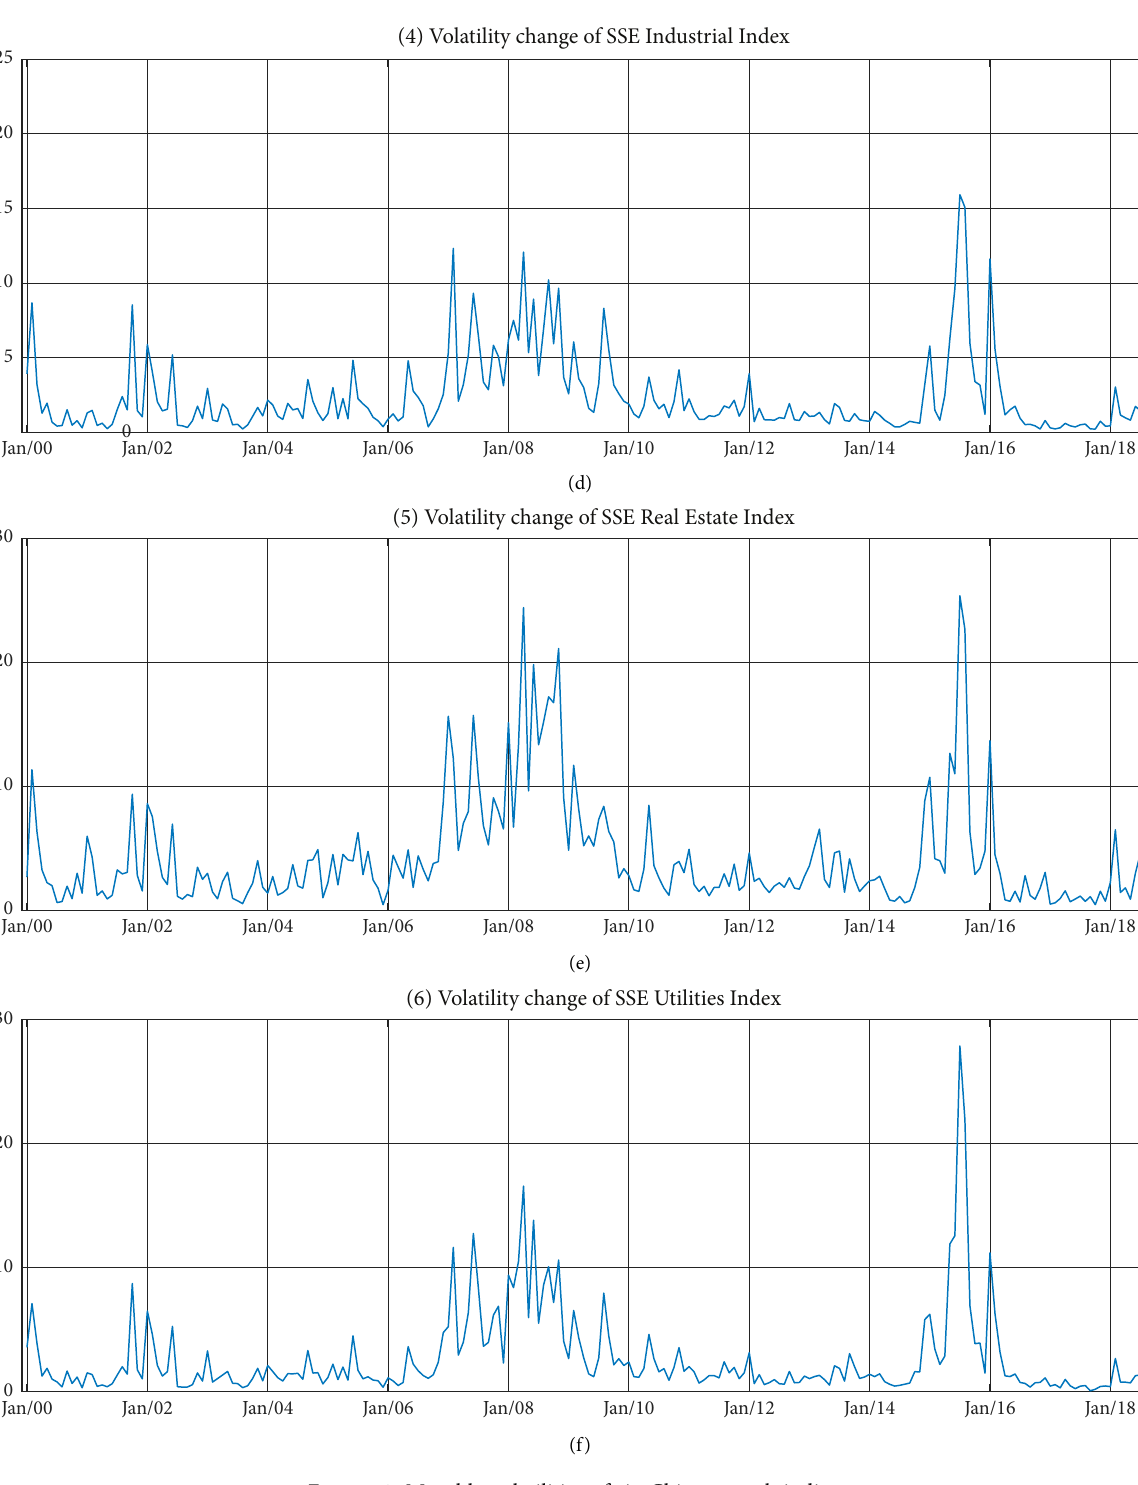
Figure 1: Monthly volatilities of six Chinese stock